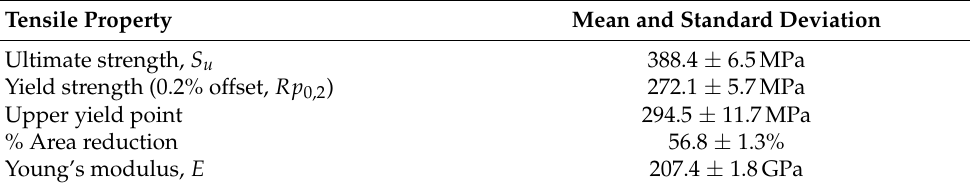
Figure 1. Stress–strain curves obtained from the tensile tests of the A37JC steel specimens. Table 2. Mean and standard deviation (across specimen orientation) of tensile properties of the base metal.